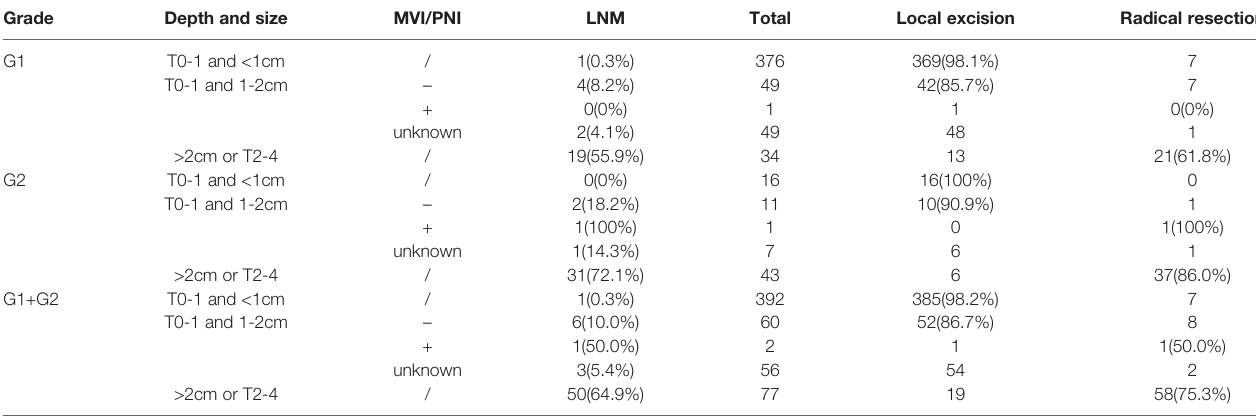
TABLE 4 | Treatment modalities according to consensus guideline (n =